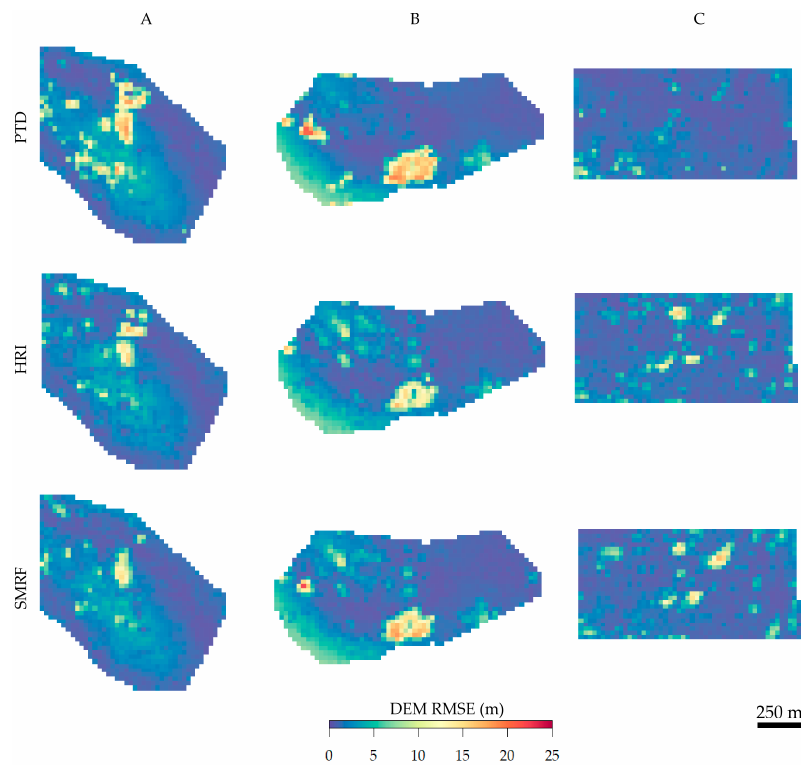
Figure 6. Spatial distribution of the ALS vs. DAP-DEM RMSE averaged using 25 × 25 m cells for the three study areas and ground classification methods. Remote Sens. 2019 , 11 , x FOR PEER REVIEW